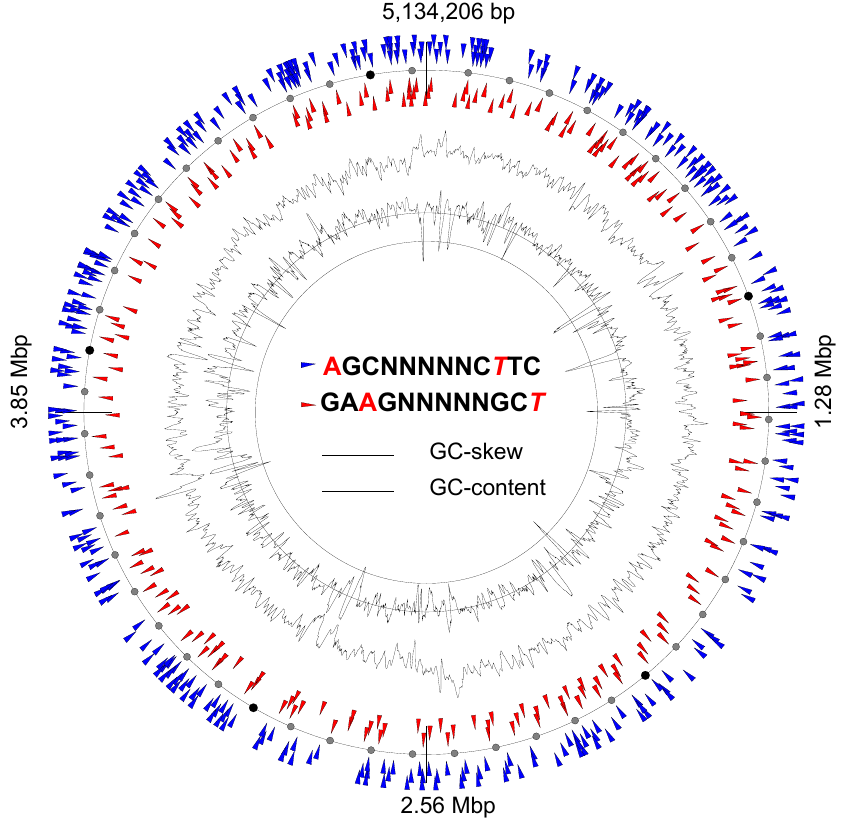
Figure 3. Atlas presentation of the circular chromosome of the strain E. coli 3/145. Locations of motifs methylated at both DNA strands are depicted with colored triangles, as explained in the legend. The genomes of the P. aeruginosa 7/157 and 16/222 were methylated at motifs C A GNNNNN T GGG. These genomes had type I and type III RM systems and an orphan type I methyltransferase comprising S and M subunits. An alternative methylation motif G A CNNNNN T GCC was predicted in P. aeruginosa 9/195. This genome comprised only a single type I RM system. This change in the methylation patterns affected many genes. In total, 687 sites were methylated in the strain P. aeruginosa 16/222. Methylated nucleotides were present in the coding sequences of 268 genes and in the promoter regions of 18 genes, including an iron siderophore receptor protein, Cu-oxidizing cytochrome cbb3 , efflux pump emrA and general secretion pathway protein G. In the strain P. aeruginosa 9/195, in total, 1416 sites were methylated, which fell into the coding sequences of 555 genes and promoter regions of 31 genes involved in metabolism and one type VI secretion system component, icmF . These differences between methylation patterns could affect the gene expression in these pathogens. Three methylation motifs were identified in S. pneumoniae PHRX1-2021. In addition to the E. coli -type Dam methyltransferase, this genome comprised two type II RM systems Mja III and Xba I, and seven type I RM systems; however, many of these RM systems ap- peared truncated. It was not clear which of these type I systems remained active, as only one type I motif was found among the methylated sites (Table 5). This example showed that methylation patterns may change either due to the acquisition of new methyltrans- ferases or the inactivation of available RM systems. This concept was also exemplified in the sequenced S. aureus genomes. Both genomes had two type I RM systems. However, only one methylation motif was identified in the strain S. aureus 597/2, and two alternative